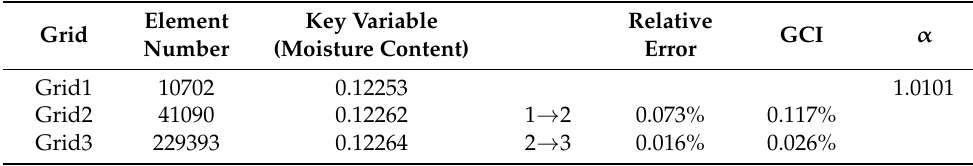
Table 2. Grid-independent